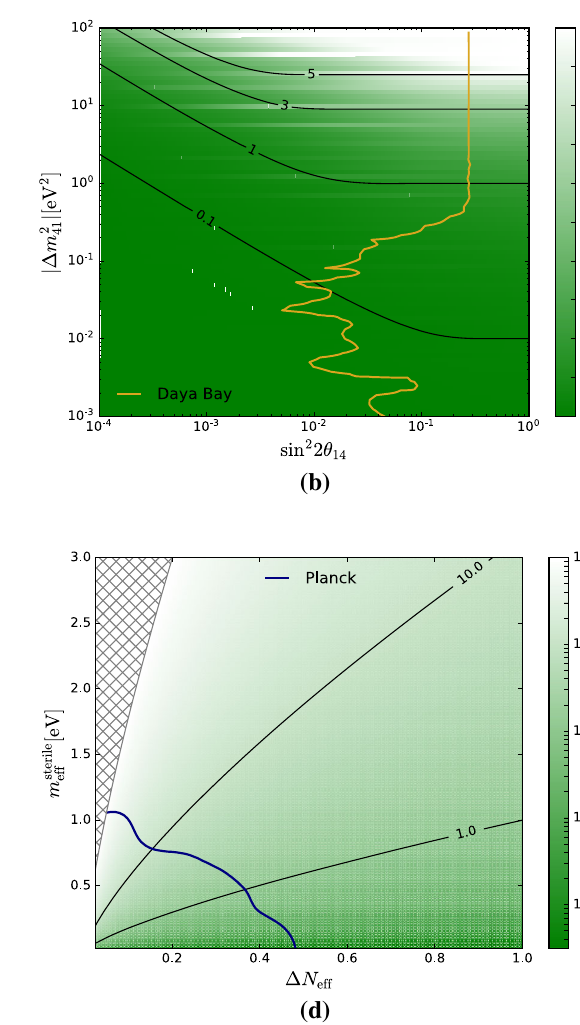
, (cid:3) N eff ) . The eff